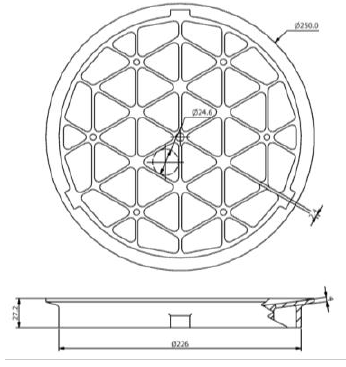
Figure 1 : Skecth of the NOPT